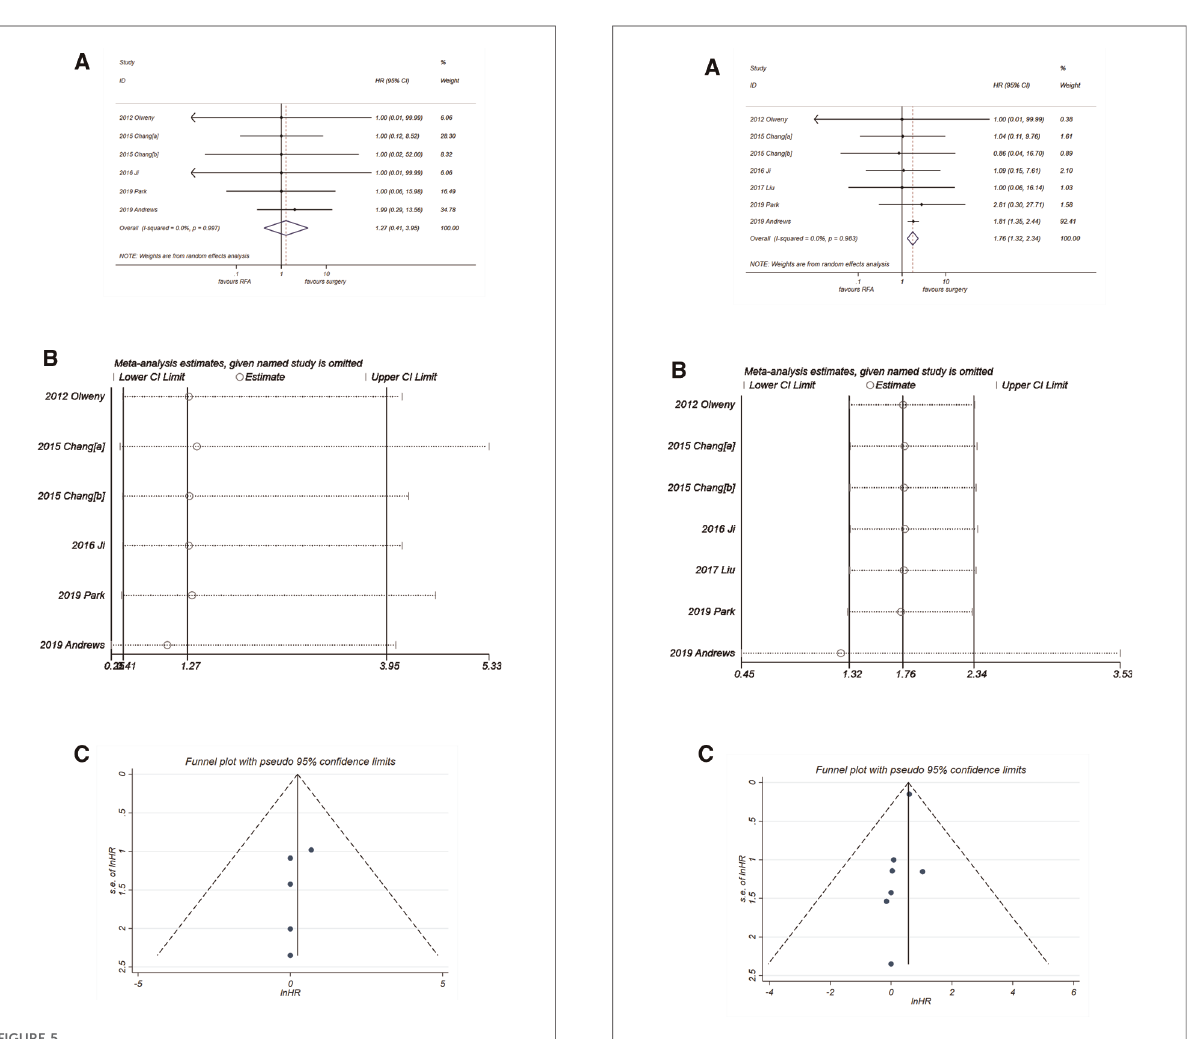
FIGURE 6 Comparison of OS of RFA vs. PN. ( A ) The forest plot shows the HR of OS of RFA vs. PN. HR>1 indicates that RFA has higher risk for OS. ( B ) Sensitivity analysis was performed by omitting one study at each analysis. The result of each analysis is also presented as the forest plot. ( C ) The funnel plot was used to detect publication bias. HR, hazard ratio; OS, overall survival; PN, partial nephrectomy; RFA, radiofrequency